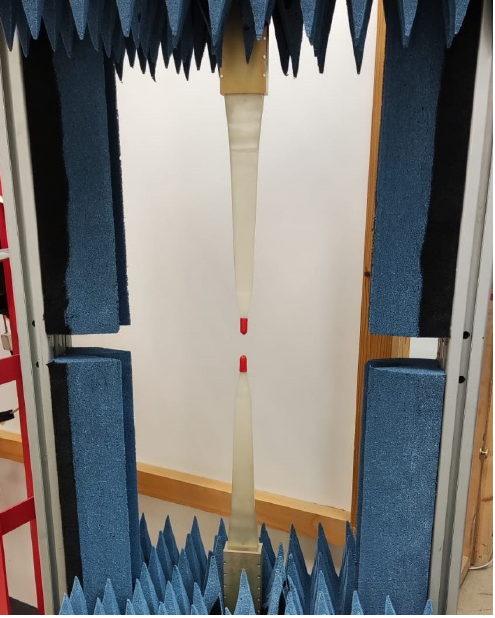
Figure 10. Vertical measurement bench with high-precision polyrod